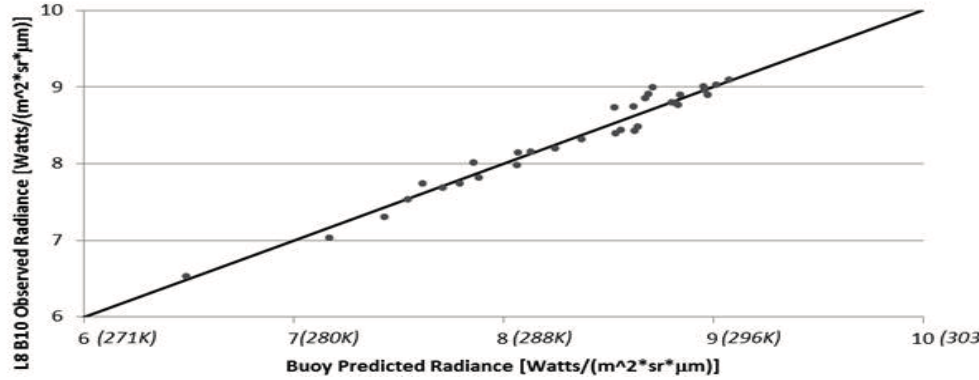
Figure 8. Plot of ToA buoy predicted radiance vs. satellite observed radiance for Landsat 8 band 10 for all data processed automatically (mean error − 0.01 K ± 0.90 K).